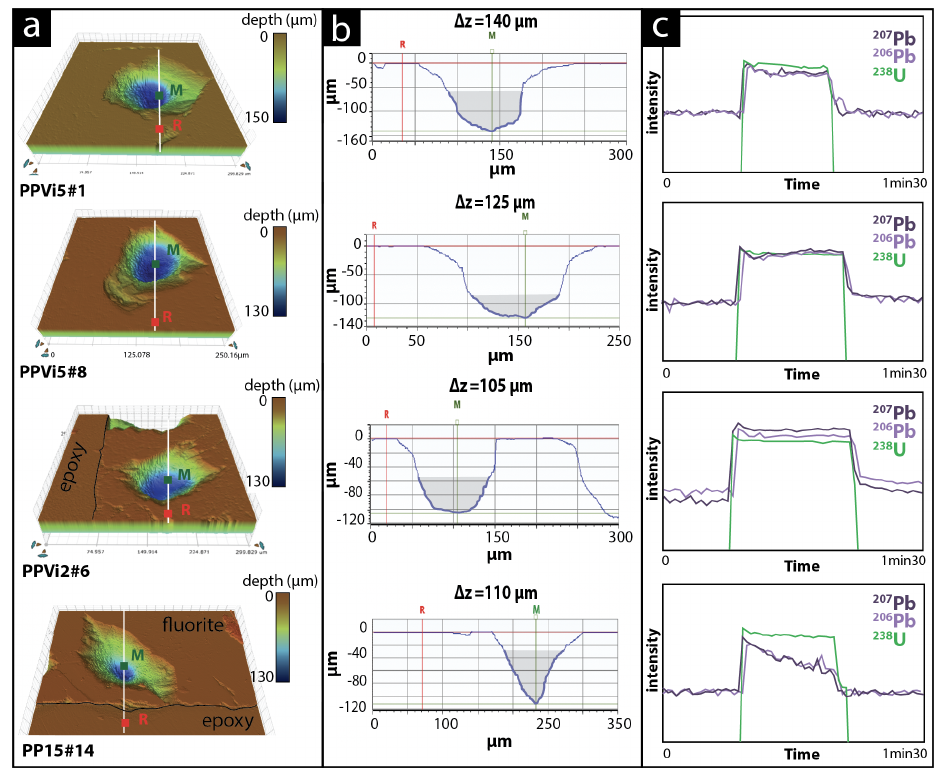
Figure A1. Various crater aspects induced by laser ablation on different fluorite sample (a) 3D surface images of craters reconstructed by an optical profilometer. (b) Corresponding 2D axial section with the measurement of crater depth thanks to two markers: R (the average value of the planar surface around the crater) and M (the deepest point in the crater) expressed as (cid:49)z (µm); illustrated in grey is the volume below a crater diameter of 85µm. (c) The corresponding LA-ICP-MS signal intensity of 238 U, 206 Pb and 207 Pb during the laser ablation. Analyses PPVi5 no. 8, PPVi5 no. 1 and PPVi2 no. 6 were included in the Tera–Wasserburg diagrams, while PP15 no. 14 is an example of an analysis discarded due to variable 238 U / 206